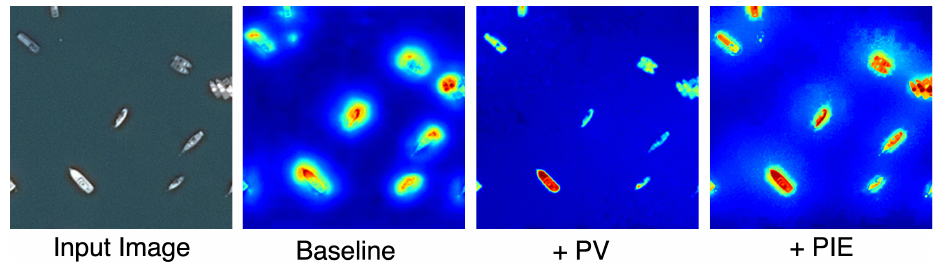
Figure 8. The visualization after adding the prototype vector and PIE